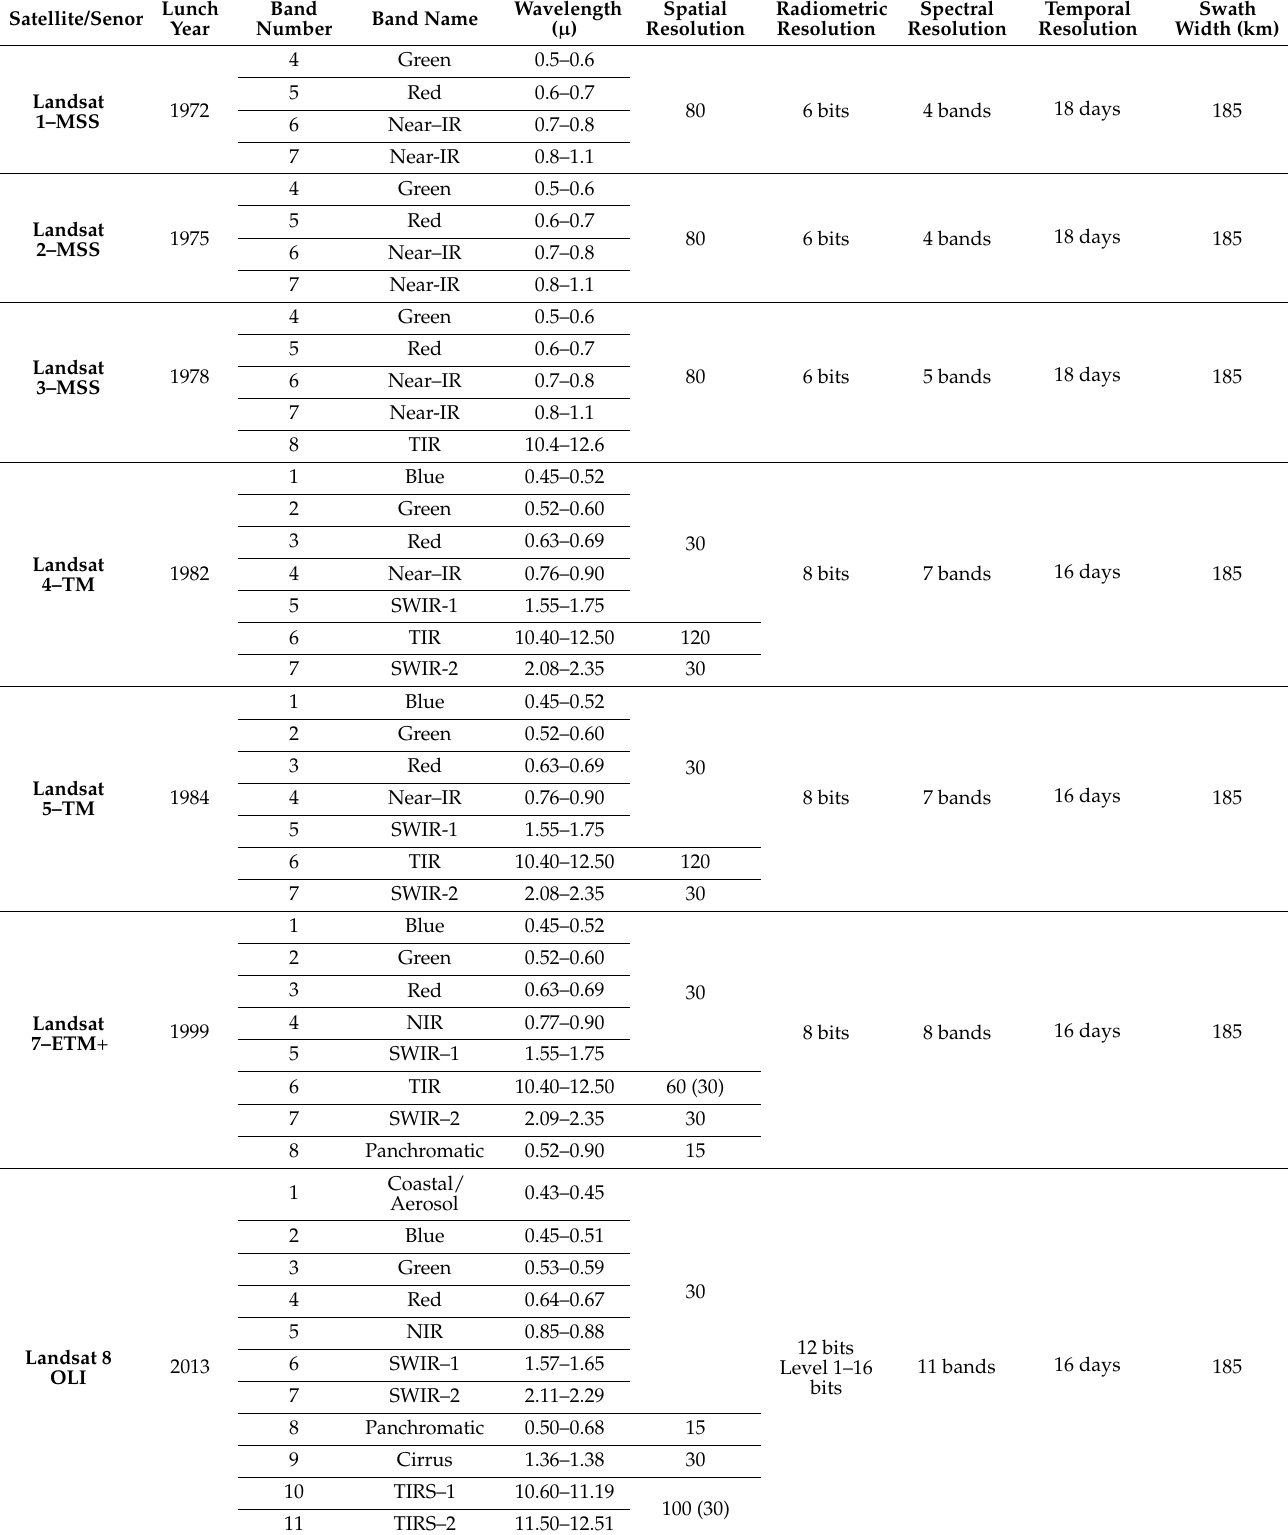
Table 1. Details of the common remote sensing data used for geological lineaments